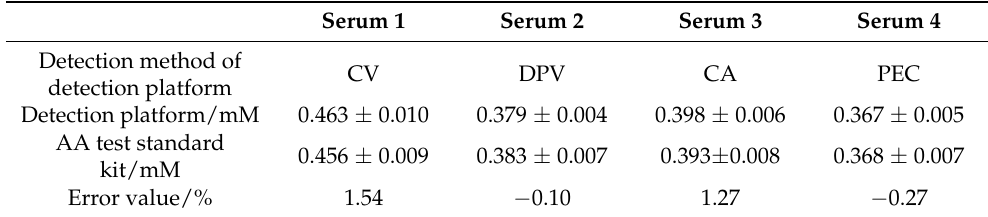
Table 2. Results of the determination of AA in different samples (n = 5).